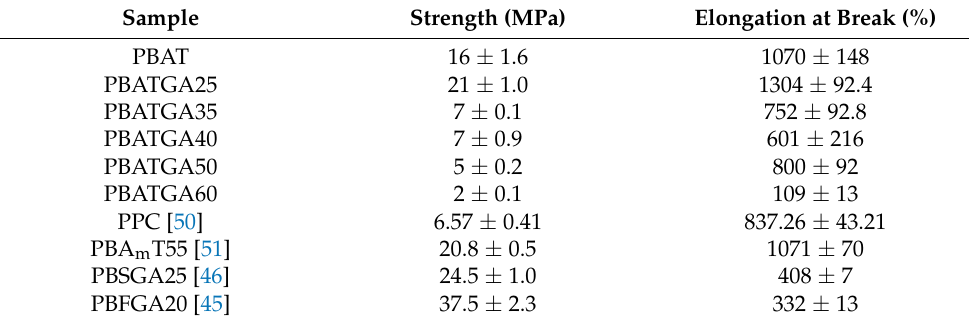
Table 4. Mechanical performance parameters of